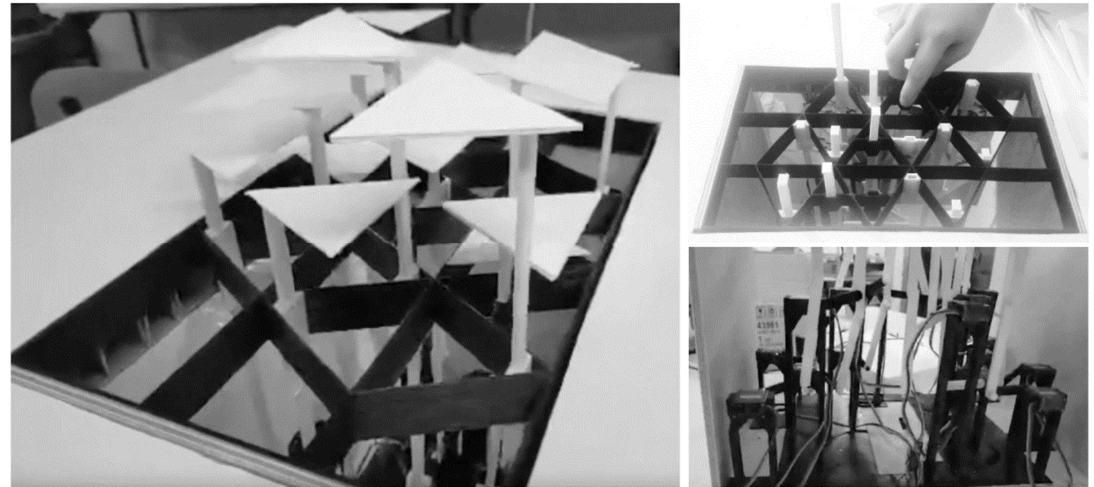
Figure 10. The view of a model illustrating the principle of operating a movable surface of a city square. ( Bottom left ) Drive system and joints responsible for the vertical movement of triangular modules. ( Bottom right ) The view of the mechanism without the triangular panels.